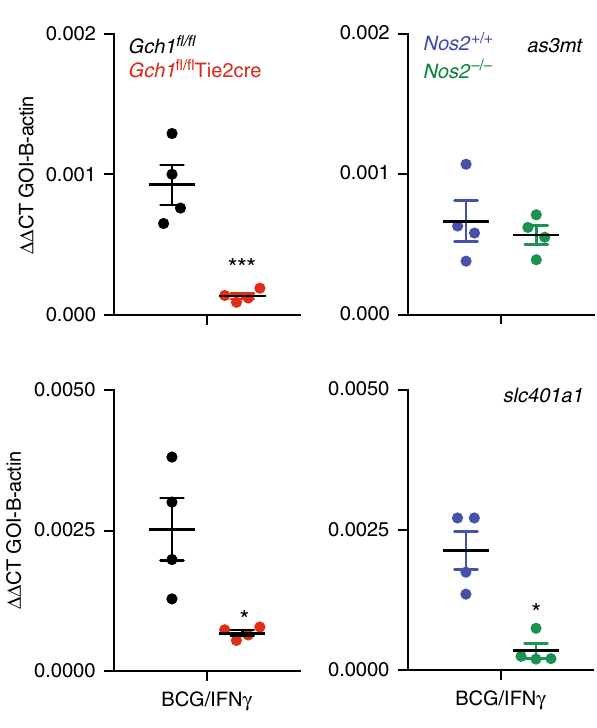
Fig. 5 Divergent gene expression changes in BH4 and iNOS-de fi cient macrophages. BMDM were prepared from Gch1 fl / fl , Gch1 fl / fl Tie2cre, Nos2 + / + and Nos2 − / − age-matched animals. Macrophages were infected at a MOI of 1:1 with BCG in the presence of 10 ng/ml IFN γ , or left uninfected followed